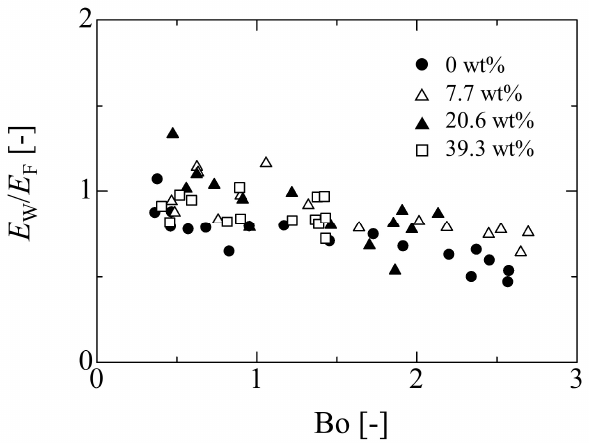
Figure 13. Relationship between Bo number and the ratio of adhesion force E W and E F . The relative errors among the adhesion forces of E W , E Fexp and E West (Equation (6)) are evaluated in Figure 14. Here, the relative error is calculated by the following relation.